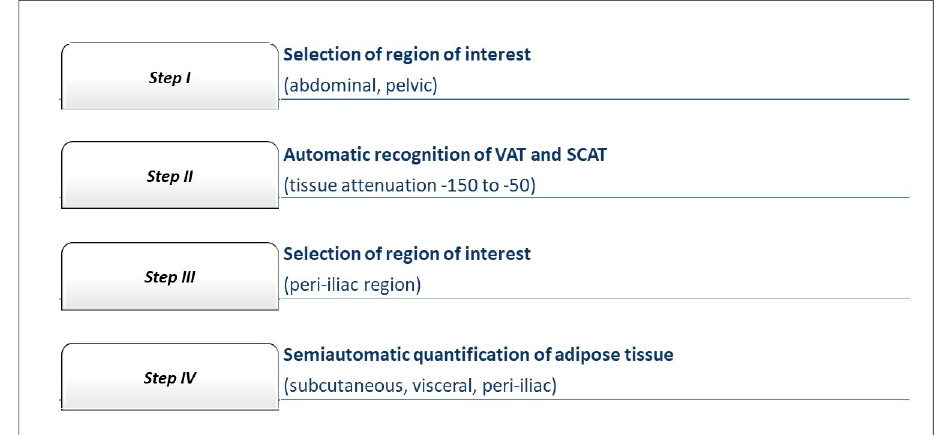
Figure 4. Flow chart of the steps for the image data postprocessing on the offline workstation.